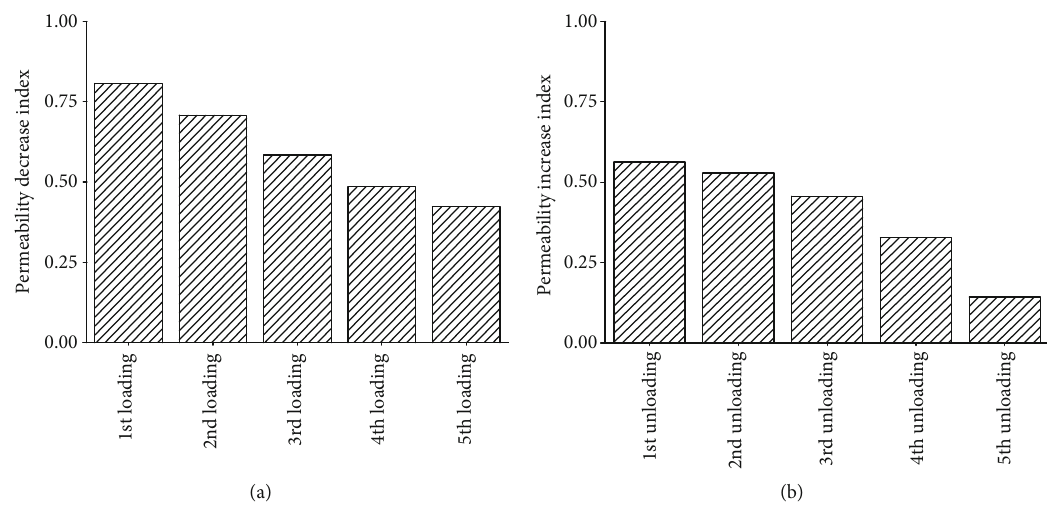
Figure 9: Permeability variation index for fractured granite specimens in all cycles of con fi ning stress.